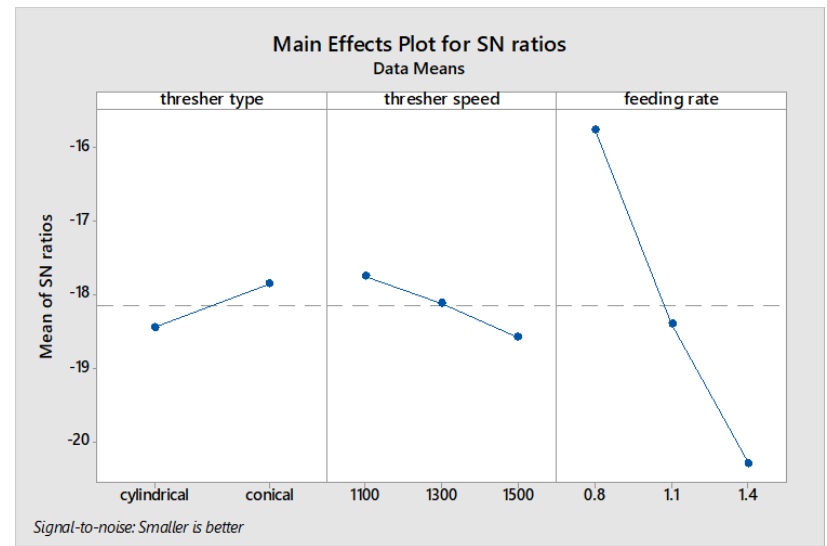
Figure 7. Effect of operating parameters on S/N ratio for power.